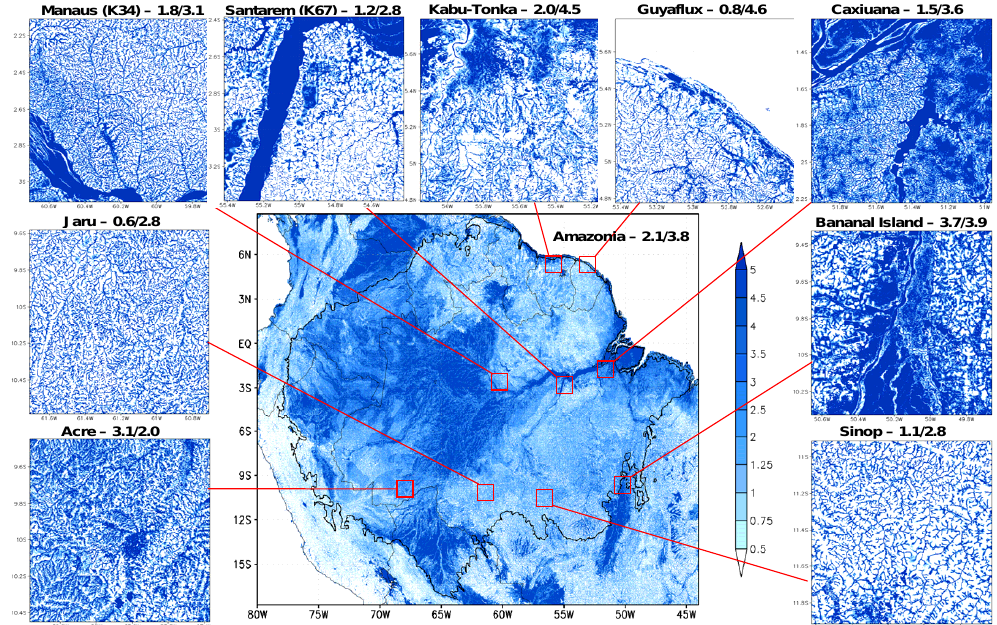
Fig. 14. Calculated equilibrium potential capillary flux (mm day -1 ) from the CLM-forced water table simulation in the Amazonia, with details around nine sites with ET estimates. The numbers given are potential capillary flux from the water table over annual mean (dry and wet season) total ET, both in mm day -1 . ET source: Manaus, Santarem, Caxiuana, Jaru and Sinop (Juarez et al., 2007), Bananal Island (Borma, et al., 2009), Guyaflux and Amazonian mean (Fisher et al., 2009), Kabu-Tonka (Poels, 1987), Acre (Duarte et al., 2008).